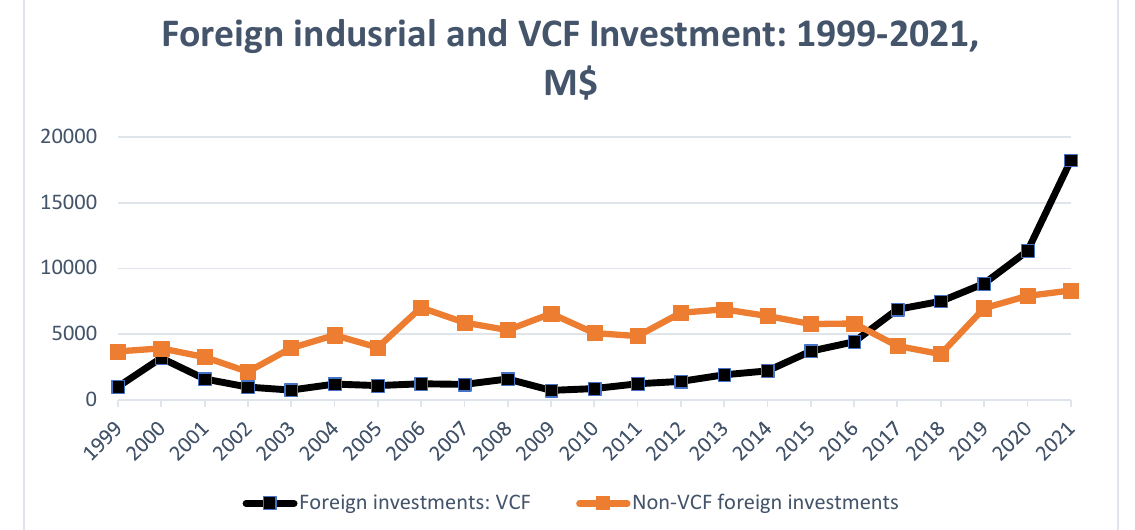
Figure 1. Foreign investment in the industrial sector and VC investment, 1999–2021. Source: authors’ analysis of Bank of Israel reports 2000–2022.